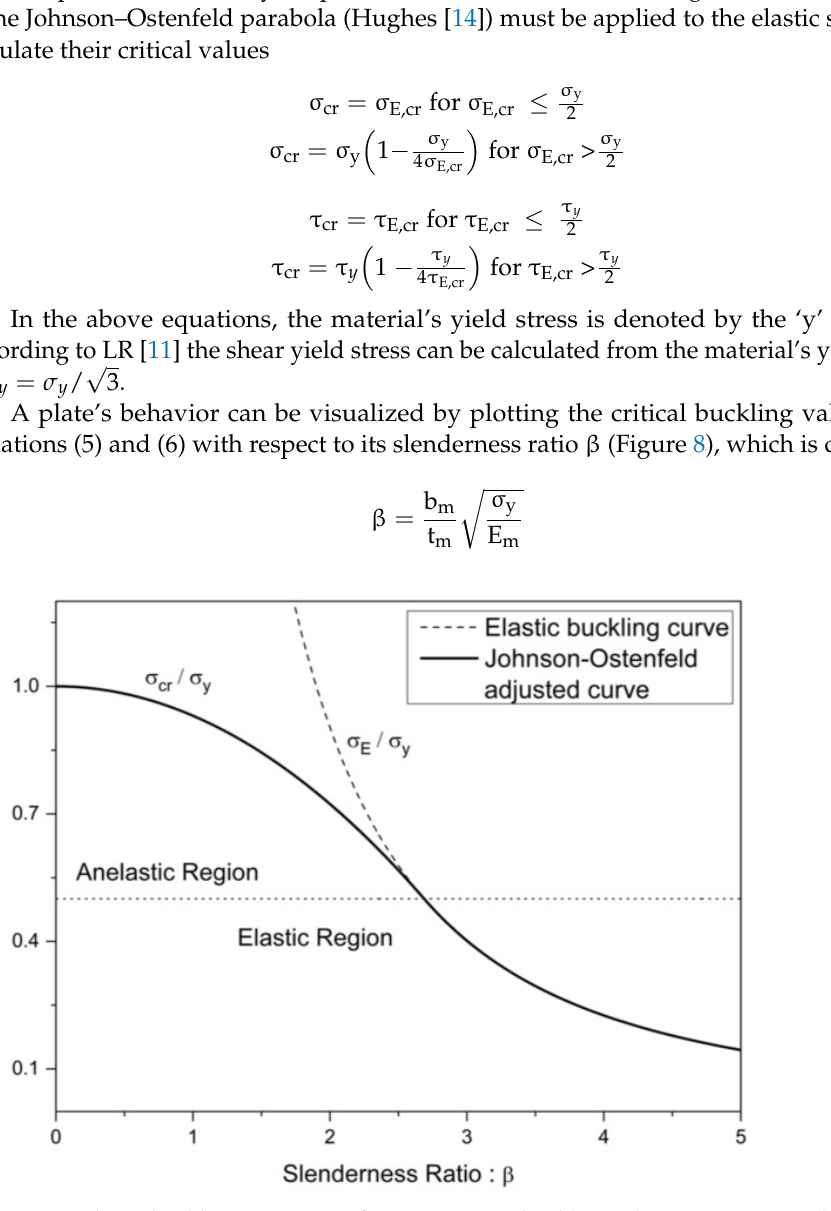
Figure 8. Anelastic buckling corrections for compressive buckling. The same curve applies to shear buckling.